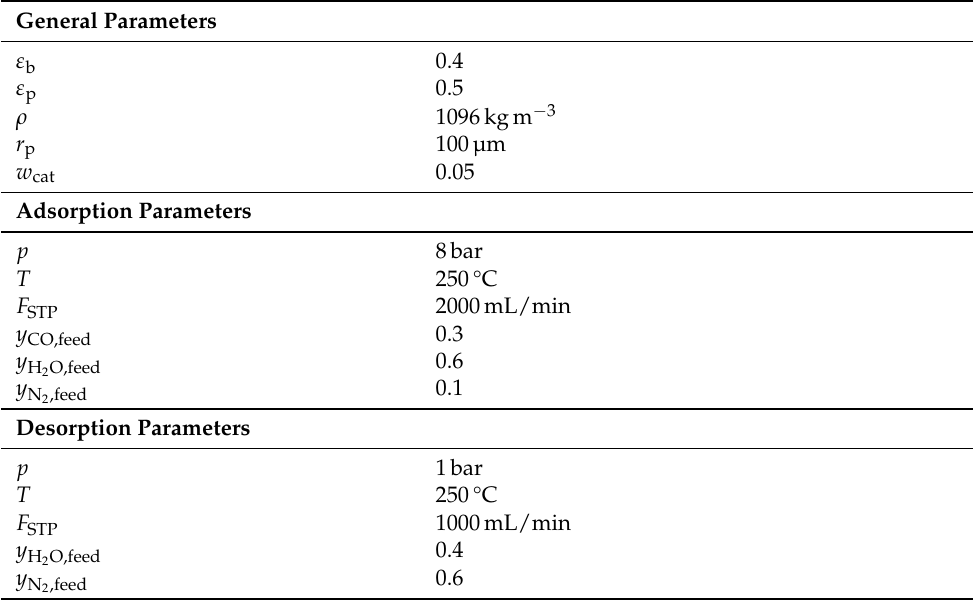
Table 2. Parameters and operating conditions used in the base case